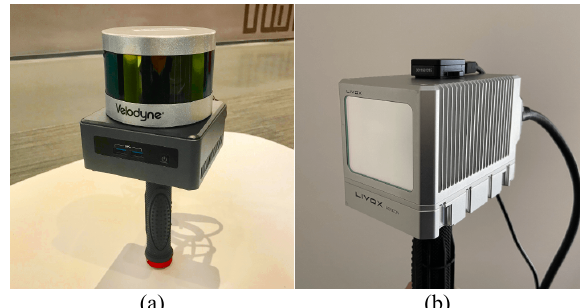
Figure 1. Two Classic handheld laser scanning system design solutions (Shan et al. ,